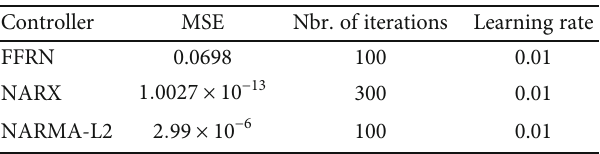
Figure 11: Example 2: (a) response of an ANN-FFNN identi fi cation model, (b) response of the plant under the FFNN controller, (c) FFNN controller output, and (d) control error with the FFNN model (using n = 3 and m = 2 Table 2: Comparison of the performance index of the proposed controller (example 2).